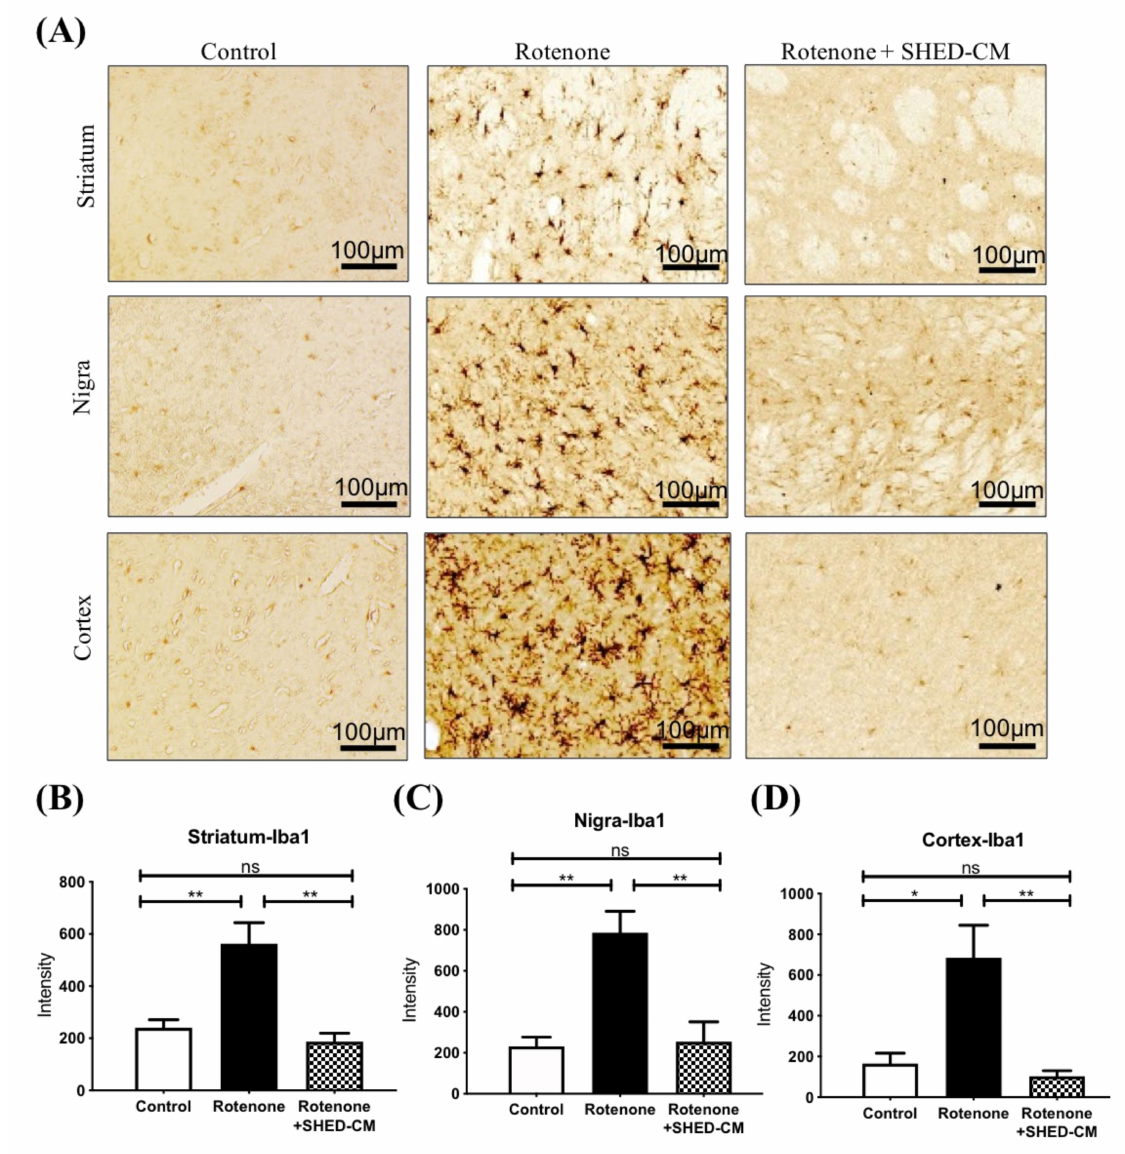
Figure 3. SHED-CM treatment reduced brain Iba-1 expression in rotenone-induced PD rats. ( A ) Immunohistochemistry staining of Iba-1-positive cells represented the activated microglia in the striatum, substantia nigra, and the cortex from the PD rats with indicated treatment. Quantification of the relative amount of Iba-1-positive cells in ( B ) the striatum, ( C ) substantia nigra, and ( D ) cortex. Each group n = 3, * p < 0.05, ** p < 0.01, ns: no significant di ff